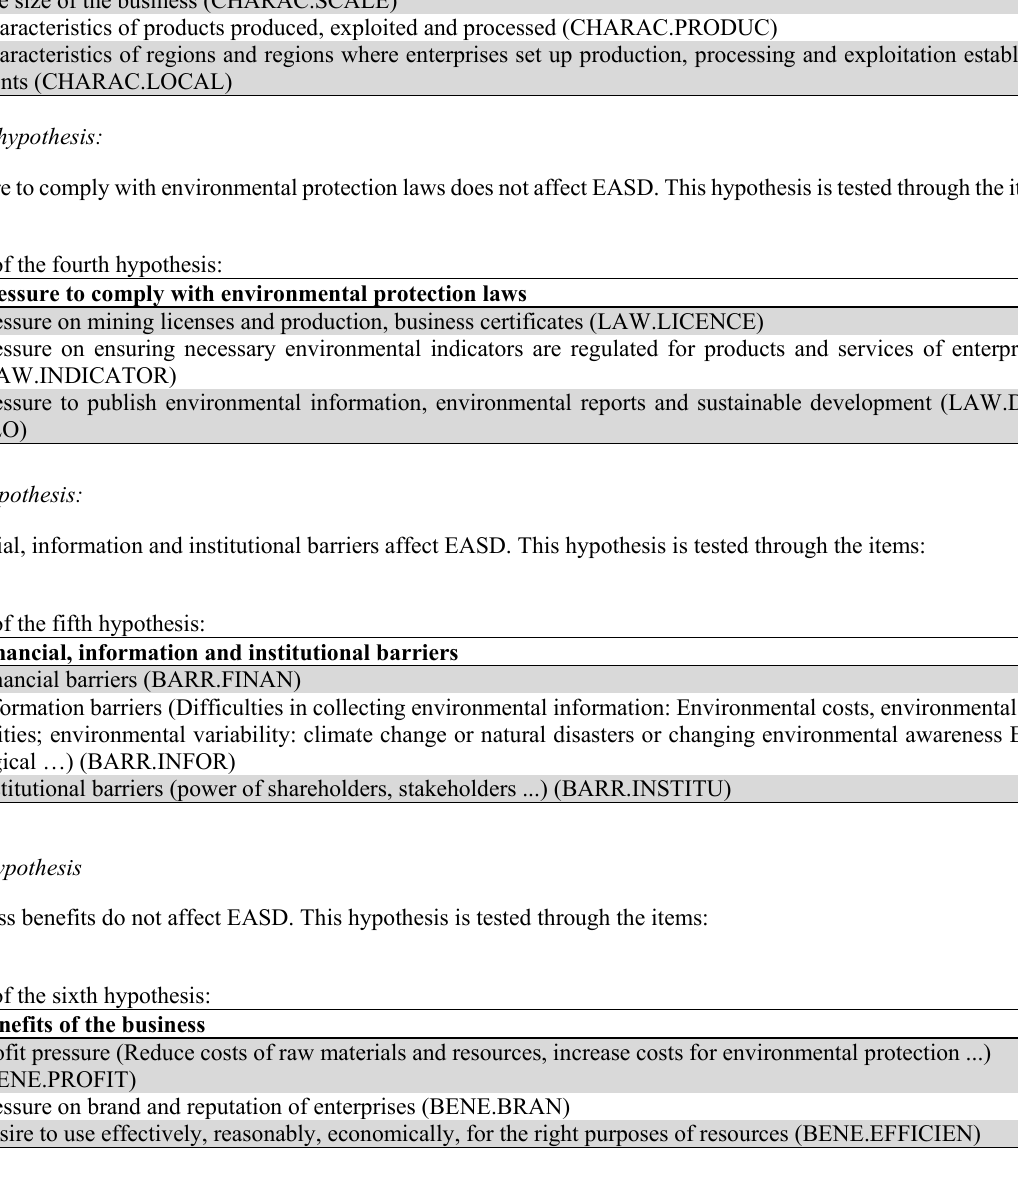
Business characteristics of enterprises